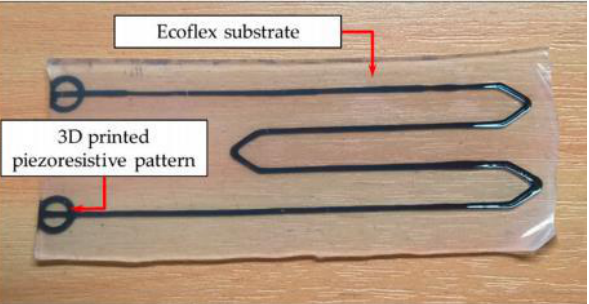
Figure 1. A large strain piezoresistive (50 mm in length) made from printed carbon-black and Eco- flex 00-30 paste [12]. The two circles on the left-hand side are the electrical connections to the